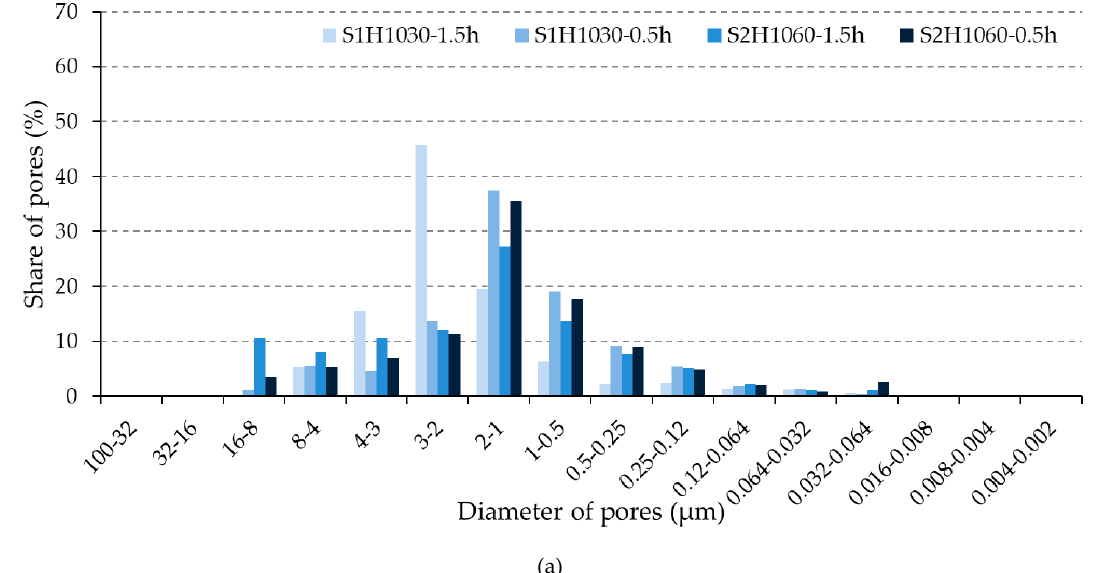
(b) Figure 6. Pore-size distribution in the ( a ) hand-made and ( b ) machine-made fired bricks.